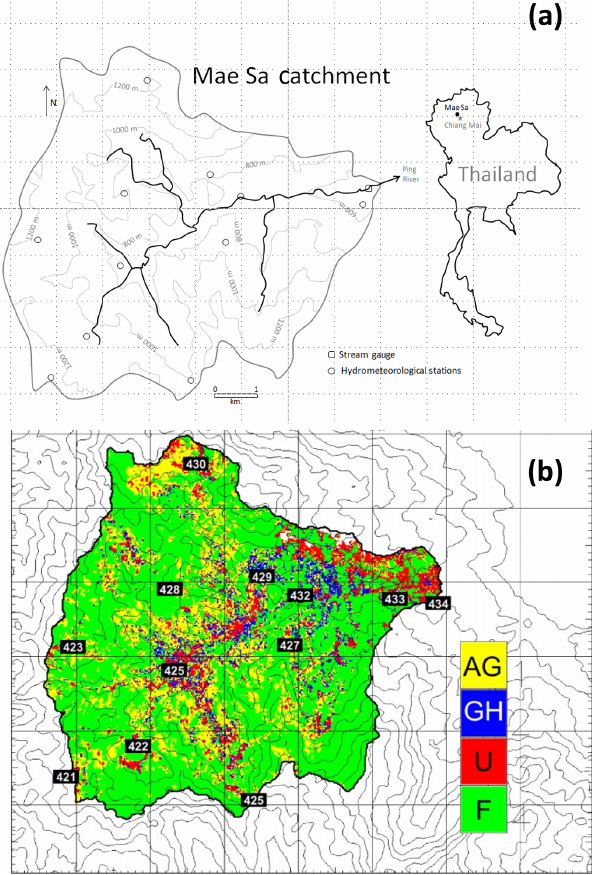
Figure 1. Site map of the Mae Sa experiment site in northern Thai- land. Panel (a) shows the catchment location in Thailand, the topog- raphy, and major stream channels. Panel (b) shows major land cov- ers in the Mae Sa catchment, including hillslope and plantation agri- culture (AG, 23%), greenhouse agriculture (GH, 7%), urbanized or peri-urban areas (U, 8%), and forest cover with various degrees of disturbance (F, 62%). Grid cell dimensions are 2km × 2km. Rect- angles demarcate hydrometeorological measurement sites. Stream- flow, total suspended solids, particulate organic carbon, and particu- late organic nitrogen were measured at the stream gauge station 434. Rainfall is measured at all other numbered hydrometeorological sta- tions (rectangles). The throughfall investigation reported in this pa- per was conducted at station 429, where rainfall, throughfall, and soil moisture were